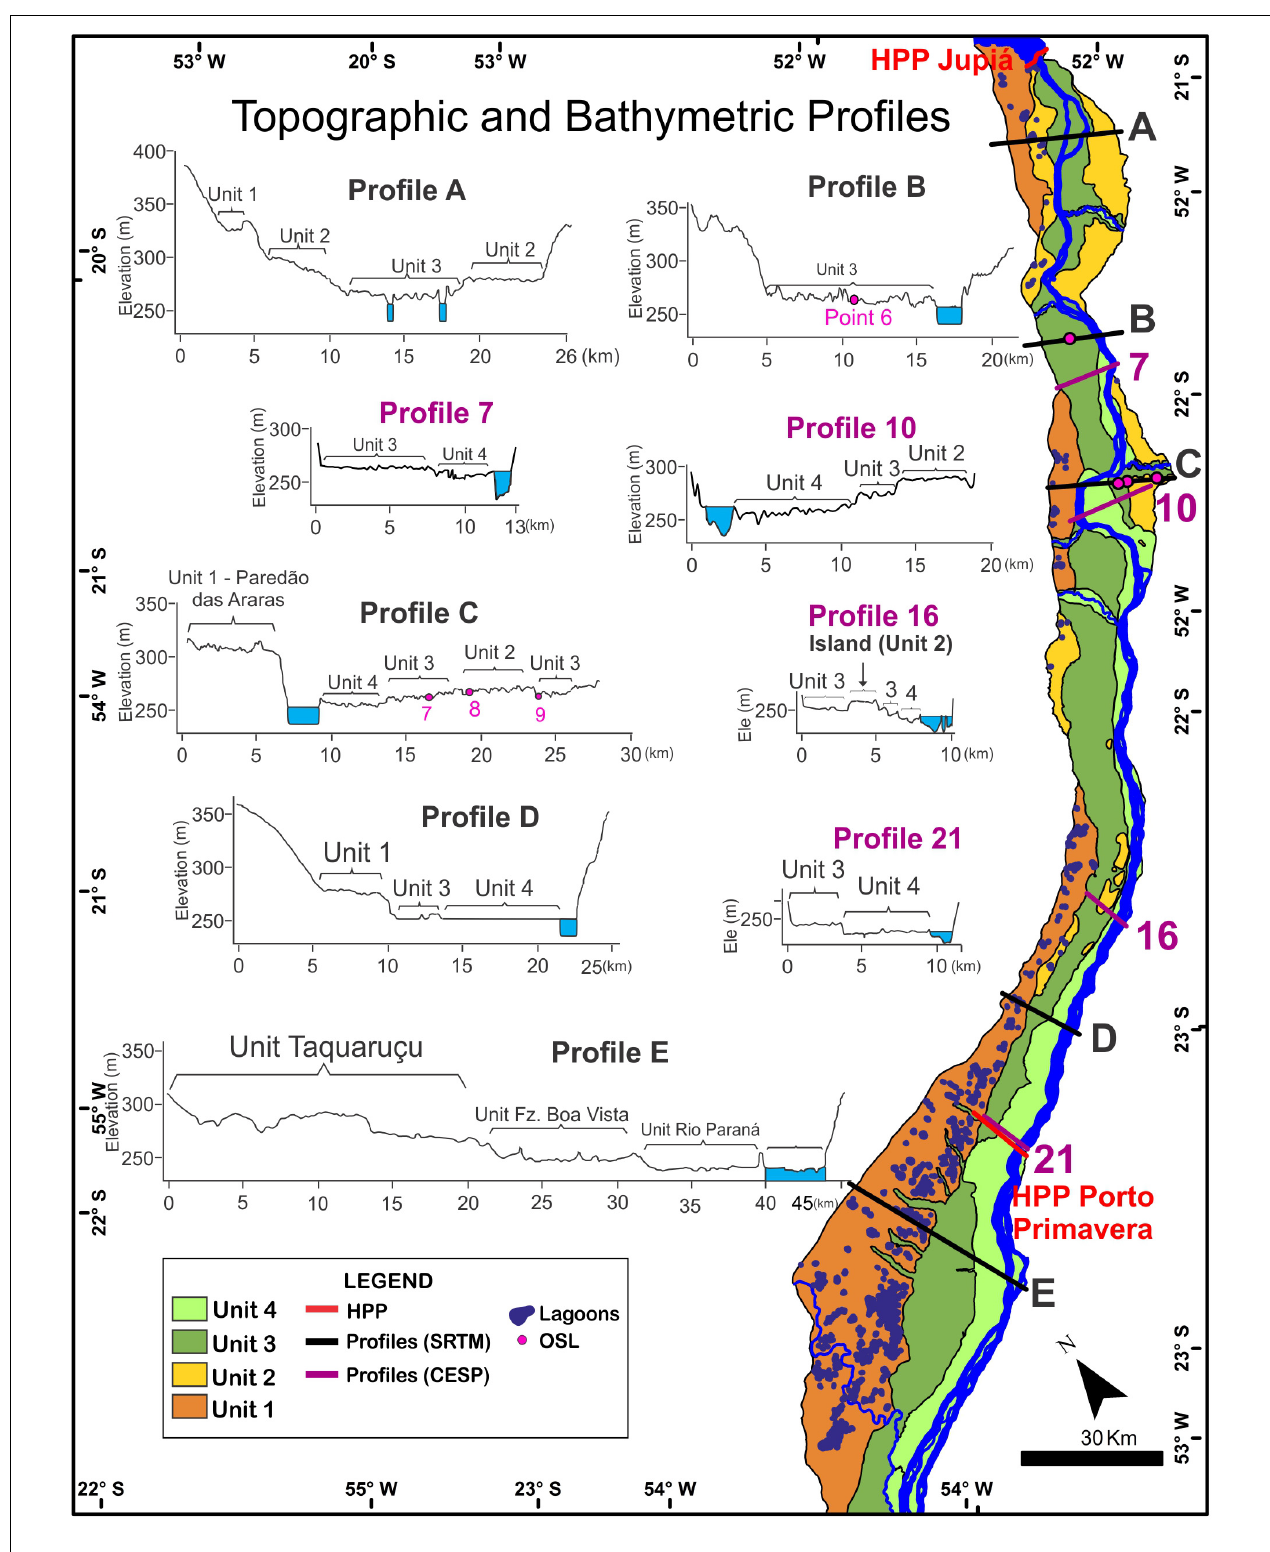
FIGURE 8 | Topographic profiles obtained from SRTM data and topobathymetric profiles elaborated by Cia Energética de São Paulo [CESP] (1997). The profiles help to correlate between the units identified in this research with the units defined by Stevaux (1994). It was also possible to identify geomorphologic units that are currently submerged due the flooding caused by the construction of the Porto Primavera reservoir.